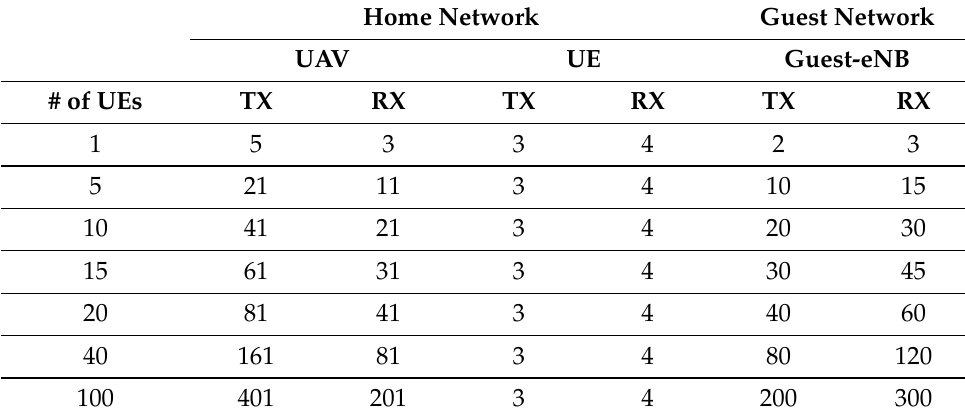
Table 3. Total number of authentication messages at fixed number of UAVs. Home Network Guest